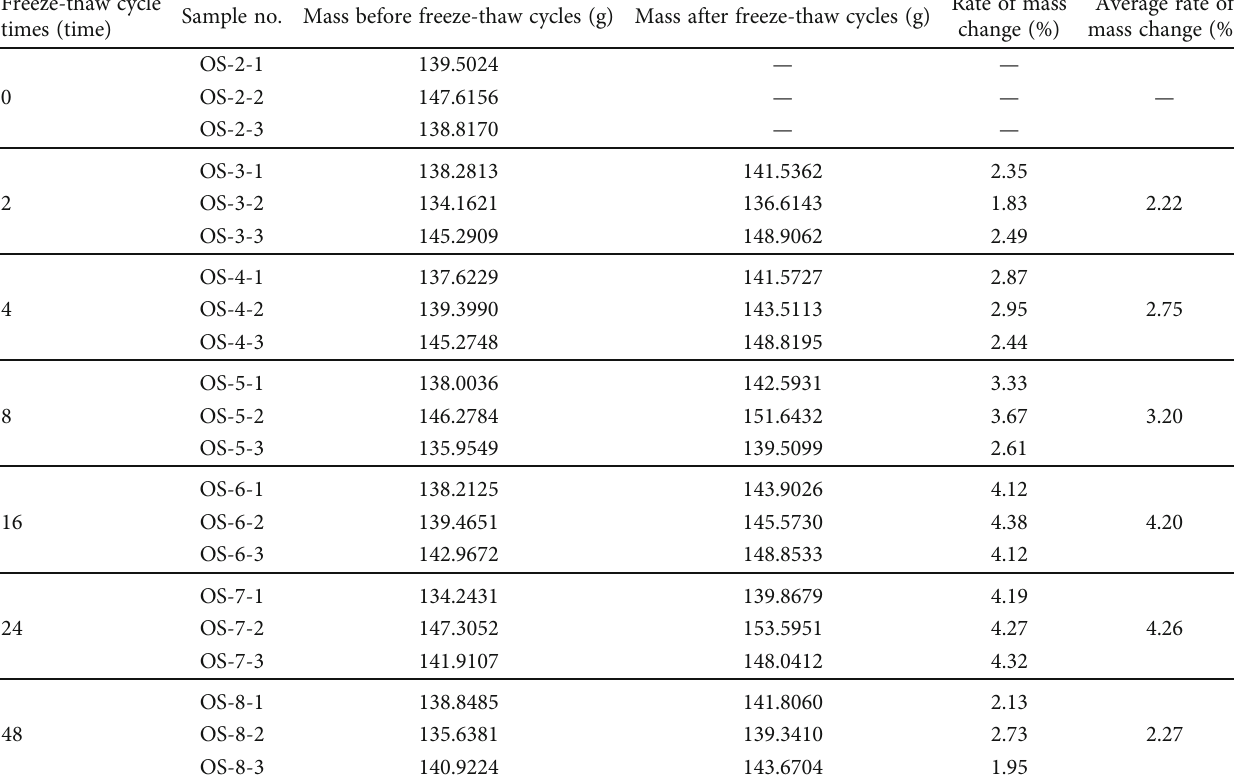
Table 3: Mass changes of oil shale samples before and after periodic freeze-thaw